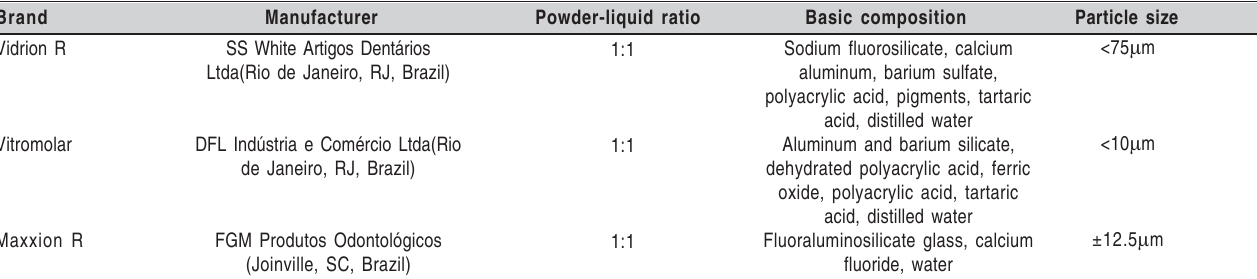
Fig. 1. 3D image of the profile of the glass ionomer cement Vidrion Table 1 – Brand, Manufacturer and powder-liquid ratio of the materials used.